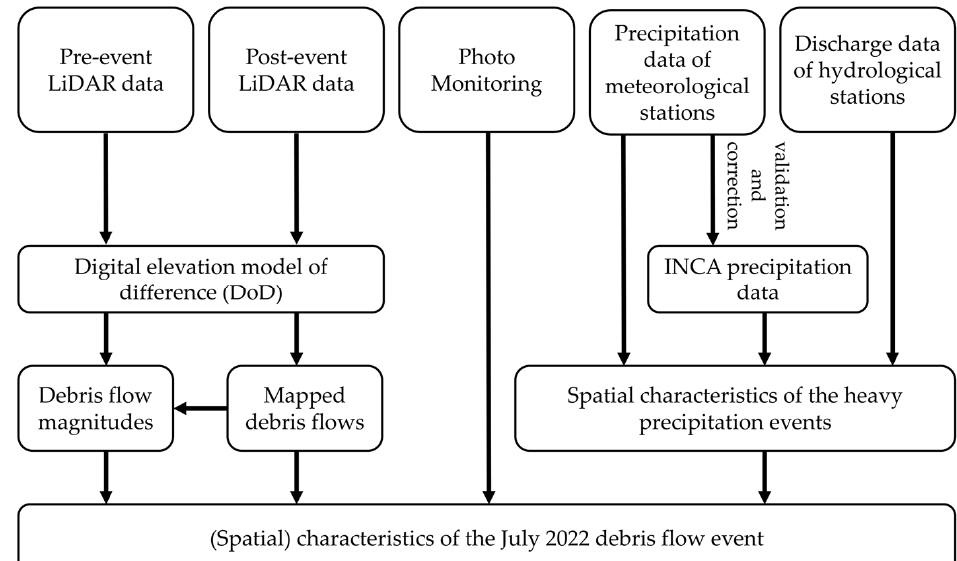
Figure 2. Technical roadmap of the study.